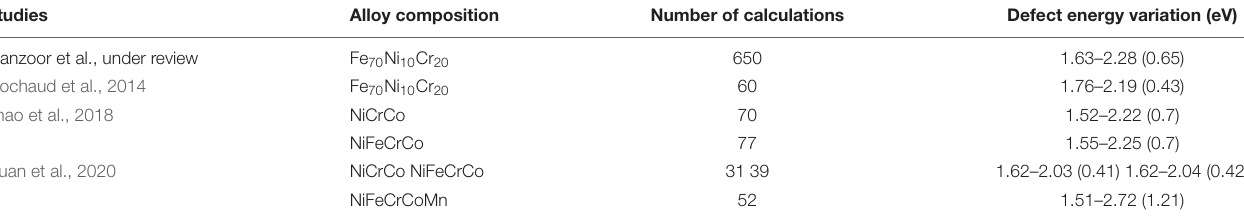
TABLE 1 | Comparison of vacancy formation energies from different studies in terms of alloy composition, number of calculations, and defect-energy variation.